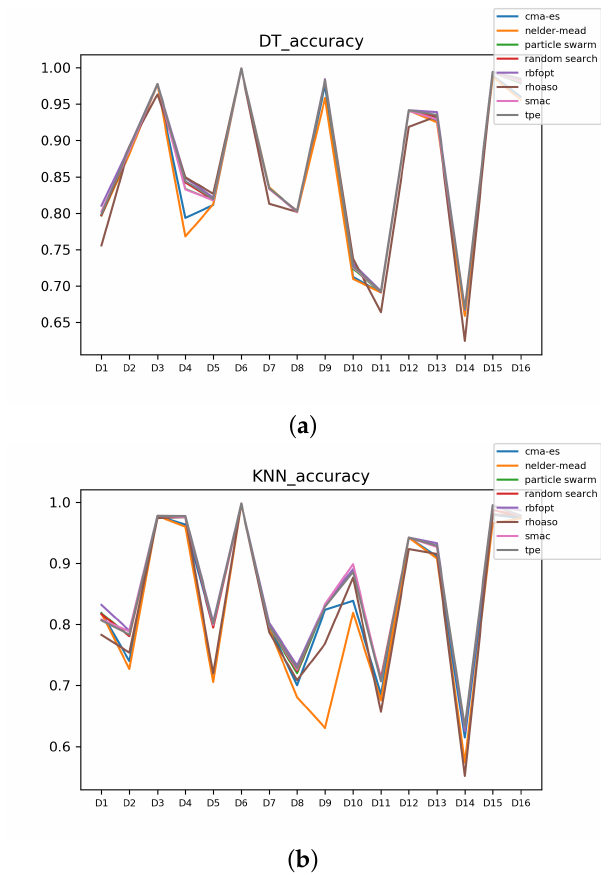
Figure A7. Accuracy complexity. ( a ) Accuracy in DT. ( b ) Accuracy in